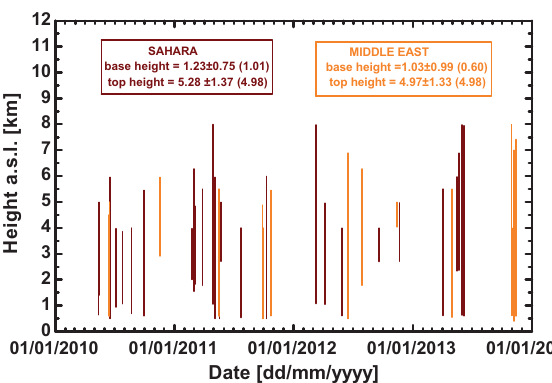
Figure 1. Lofted free–tropospheric desert dust layers (shown as ver- tical lines from bottom to top) observed between May 2010 and December 2013. The brown and orange vertical lines indicate 32 Saharan dust and 17 Middle East dust cases. The average bottom and top heights (plus the SD) of all detected dust layers are given as numbers. Median values are given in